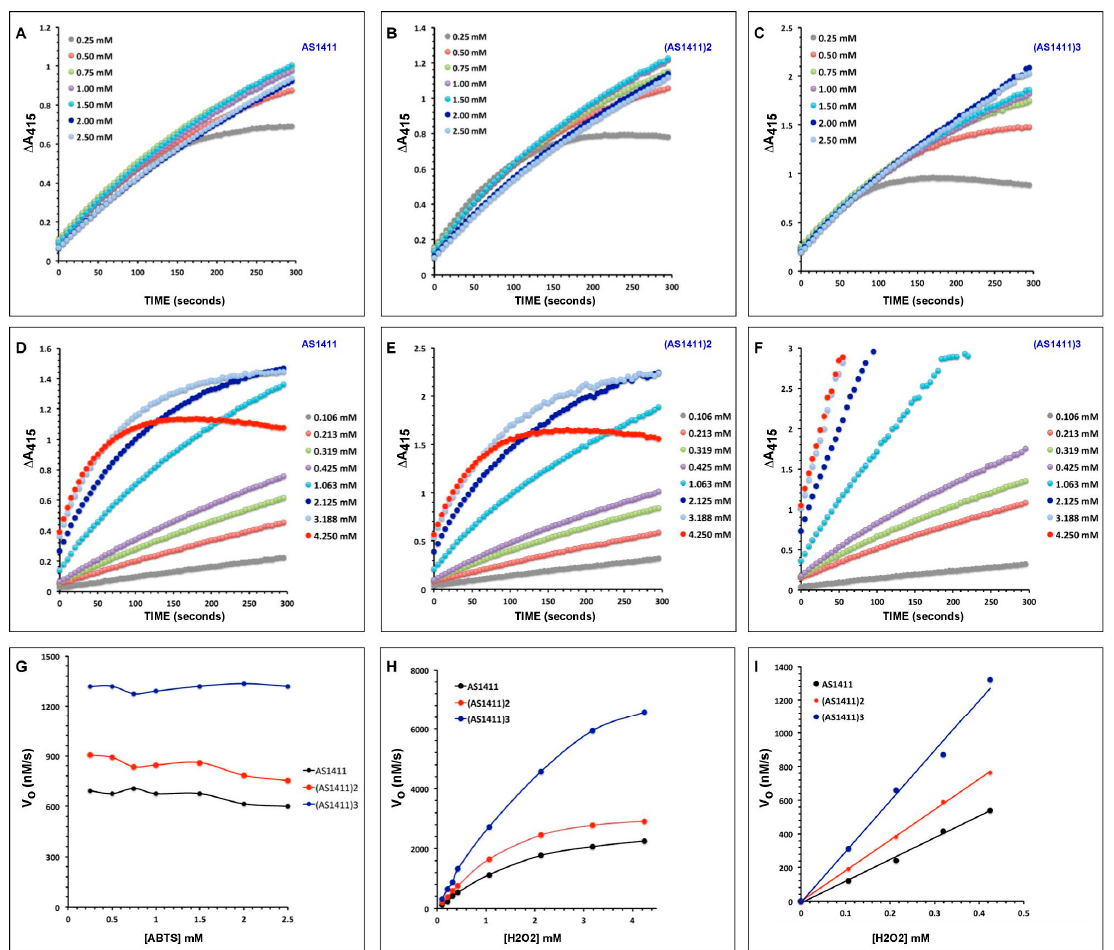
Figure 5. E ff ects of ABTS and H 2 O 2 concentrations on activities of AS1411 multimers. The e ff ects of ABTS concentrations on the time course of DNAzyme activities are shown in Panels ( A – C ). The final ABTS concentrations in the reaction mixtures are 0.25, 0.5, 0.75, 1.0, 1.5, 2.0, and 2.5 mM. Reactions were carried out at a fixed H 2 O 2 concentration (0.425 mM), and 1.0 µ M DNAzyme. Similarly, Panels ( D – F ) show the e ff ects of H 2 O 2 concentrations on the time course of reactions at a fixed ABTS concentration (2.5 mM), and 1.0 µ M DNAzyme. The final H 2 O 2 concentrations are 0.106, 0.213, 0.319, 0.425, 1.063, 2.125, 3.188, and 4.250 mM. The relationship between substrate concentrations and Initial Rates are shown in Panel ( G ) (ABTS) and Panel ( H ) (H 2 O 2 ). Panel ( I ) shows the linear relationship between Initial Rates and H 2 O 2 concentration at lower concentrations of the reactant (0.106, 0.213, 0.319, and 0.425 mM). Initial Rates (expressed as V o , nM / s) were calculated from the slope of the initial linear portion of the curves in ( A – F) .